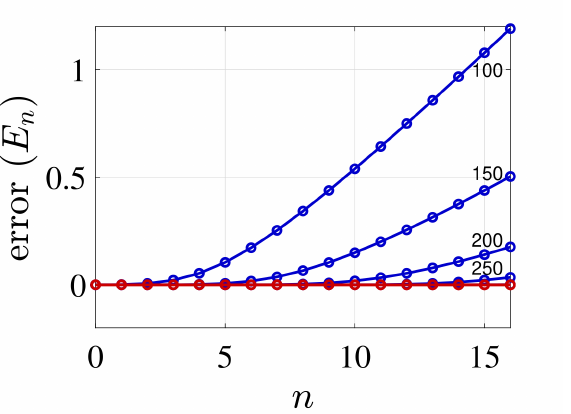
Figure 3. Error of the energy eigenvalues, n = 0,1,2, . . ., for the harmonic potential using the standard (non variational) FDM (red curves) and the present (variational) FDM (blue curves). Red curves for fixed value of L max = 36 for growing number of grid points N (N = 100,150, . . . ,250), and blue curves ∆ x = δ x = L max / N max . The parameters values are: ω = µ = ¯ h = 1 and the kinetic energy is evaluated utilizing m = 7 grid points. For the harmonic potential, the upper variational solutions obtained by the present FDM converge much slower relative to the non-variational solutions, obtained by the standard FDM. On the scale of this graph it is not possible to follow the convergence of the non-variation (red) results obtained for N ≥